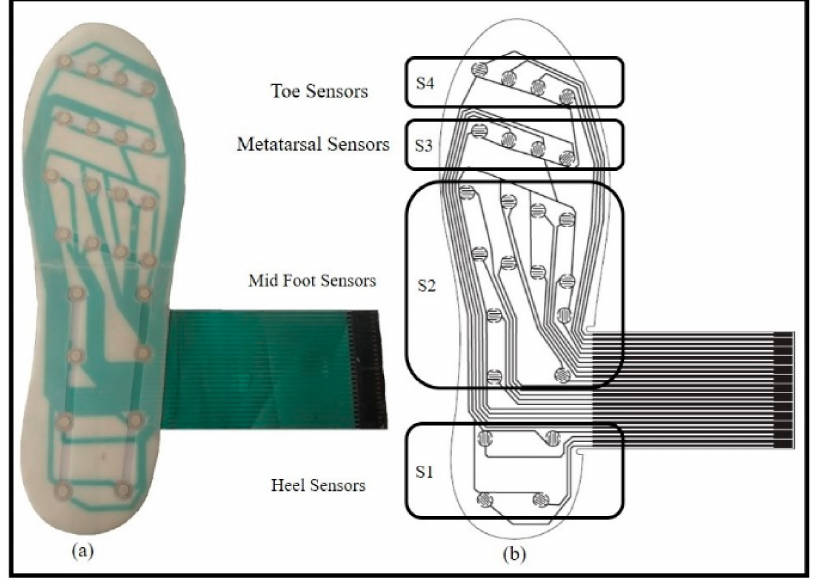
Figure 2. ( a ) Photograph of plantar insole and ( b ) sensor grouping.